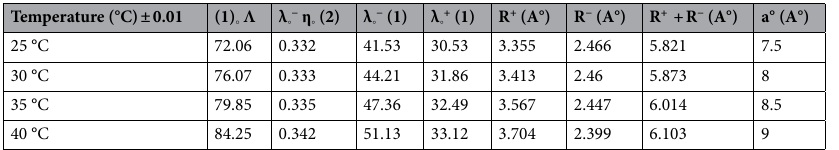
Temperature (°C) ± 0.01